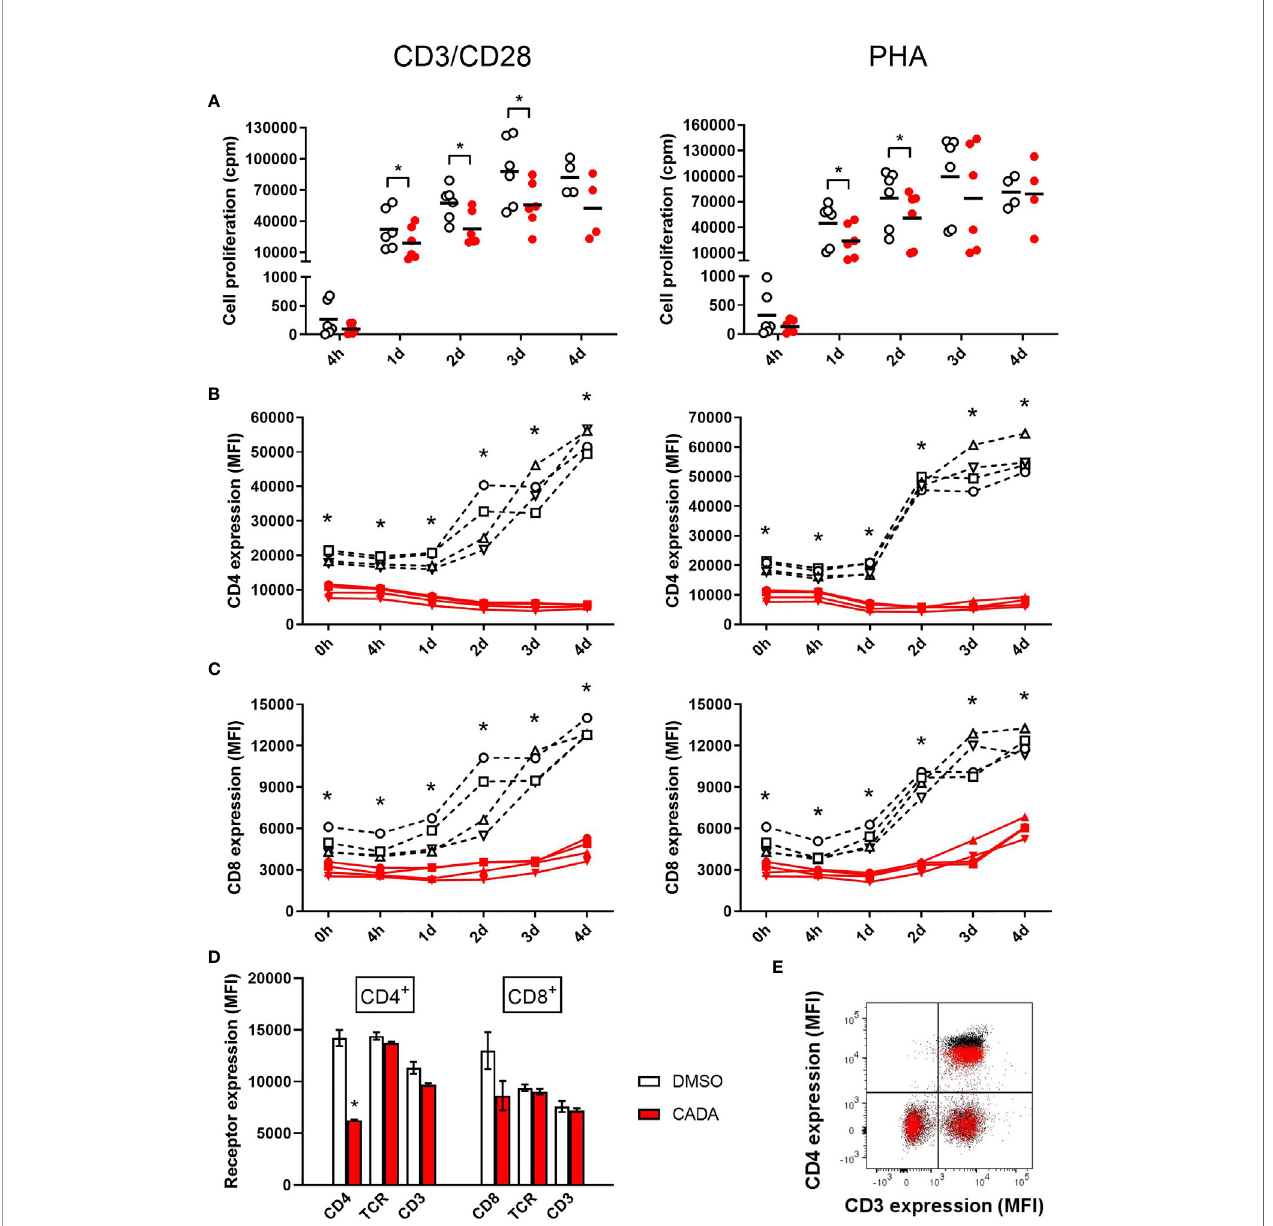
FIGURE 2 | CADA suppresses lymphocyte proliferation and inhibits upregulation of CD4 and CD8 after activation by CD3/CD28 beads or PHA. (A) PBMCs were pre-incubated with CADA (10 m M) or DMSO during 3 days, after which they were activated by CD3/CD28 beads (left panels) or PHA (right panels). At 4h, 1d, 2d, 3d or 4d post activation, [ 3 H]-thymidine was added and proliferation response was measured by detecting counts per minute (cpm) 22h later. Individual cpm values are shown for stimulated PBMCs with DMSO-treated cells as open symbols and CADA-treated cells as solid red dots. A paired t-test was performed to compare CADA to DMSO with *p<0.05. Horizontal lines indicate the mean values of 4 to 6 donors (n=6, except for time point 4d where n=4). (B, C) Cell surface CD4 (B) and CD8 (C) receptor expression was measured by fl ow cytometry just before activation (0h) and 4h, 1d, 2d, 3d or 4d post activation with CD3/CD28 (left) or PHA (right). Mean fl uorescence intensity (MFI) of human CD4 or CD8 receptor expression is shown for different donors of PBMCs (indicated separately) with DMSO-treated samples as a black dotted line and CADA-treated samples as a red line. Curves are showing single MFI values of the indicated receptor (acquired from at least 5,000 cells per donor) for four different donors (n=4). (D) PBMCs were incubated with CADA (10 m M) or DMSO for 3 days, and subsequently analyzed for cell surface receptors CD3, CD4, CD8 and TCR a / b . Bar diagrams are showing the MFI of the indicated receptor on gated CD4 + or CD8 + subpopulations, with DMSO in white and CADA in red. Welch ’ s corrected t-tests were performed to compare CADA to DMSO with *p<0.05. Values represent mean ± SD of two different donors (n=2). (E) PBMCs were stimulated with PHA for 3 days and were subsequently exposed to CADA (10 µM) or DMSO for another 2 days. Dot plot represents cell surface expression of CD3 and CD4, with DMSO as black dots and with CADA as red overlay. Do note that the CADA-treated cells have similar CD3 expression levels as DMSO, but reduced CD4 levels (see difference in black and red population in upper right quadrant). See also Supplementary Figure 3